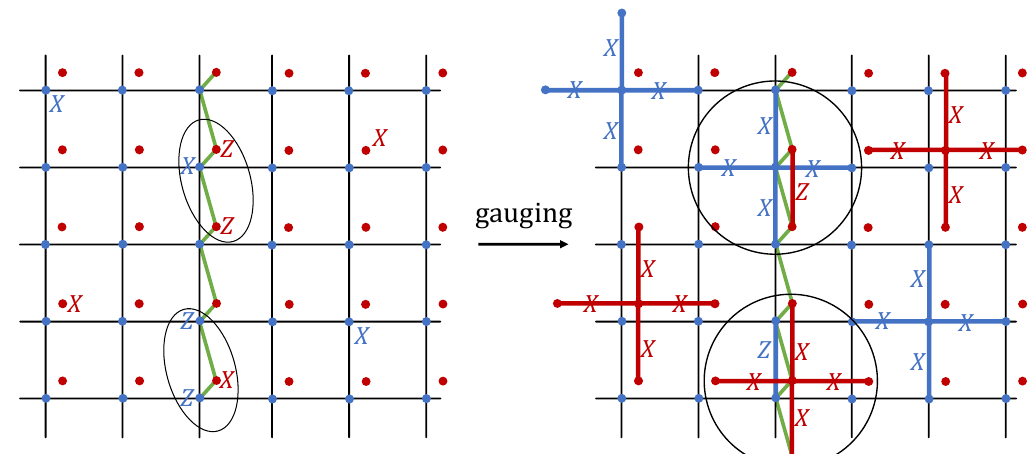
Figure 6: Left: each blue or red dot represents a qubit. The cluster state is decorated on the defect (green line), which makes the Hamiltonian having Pauli X coupled to adjacent Pauli Z ; otherwise, each dot gives Pauli X to the Hamiltonian. Right: after × (cid:90) gauging (cid:90) symmetry, the singe Pauli X away from the defect becomes the X - 2 2 star term. On the twist string, the X -star term is dressed with an additional Z of a different color due to the cluster state Hamiltonian.